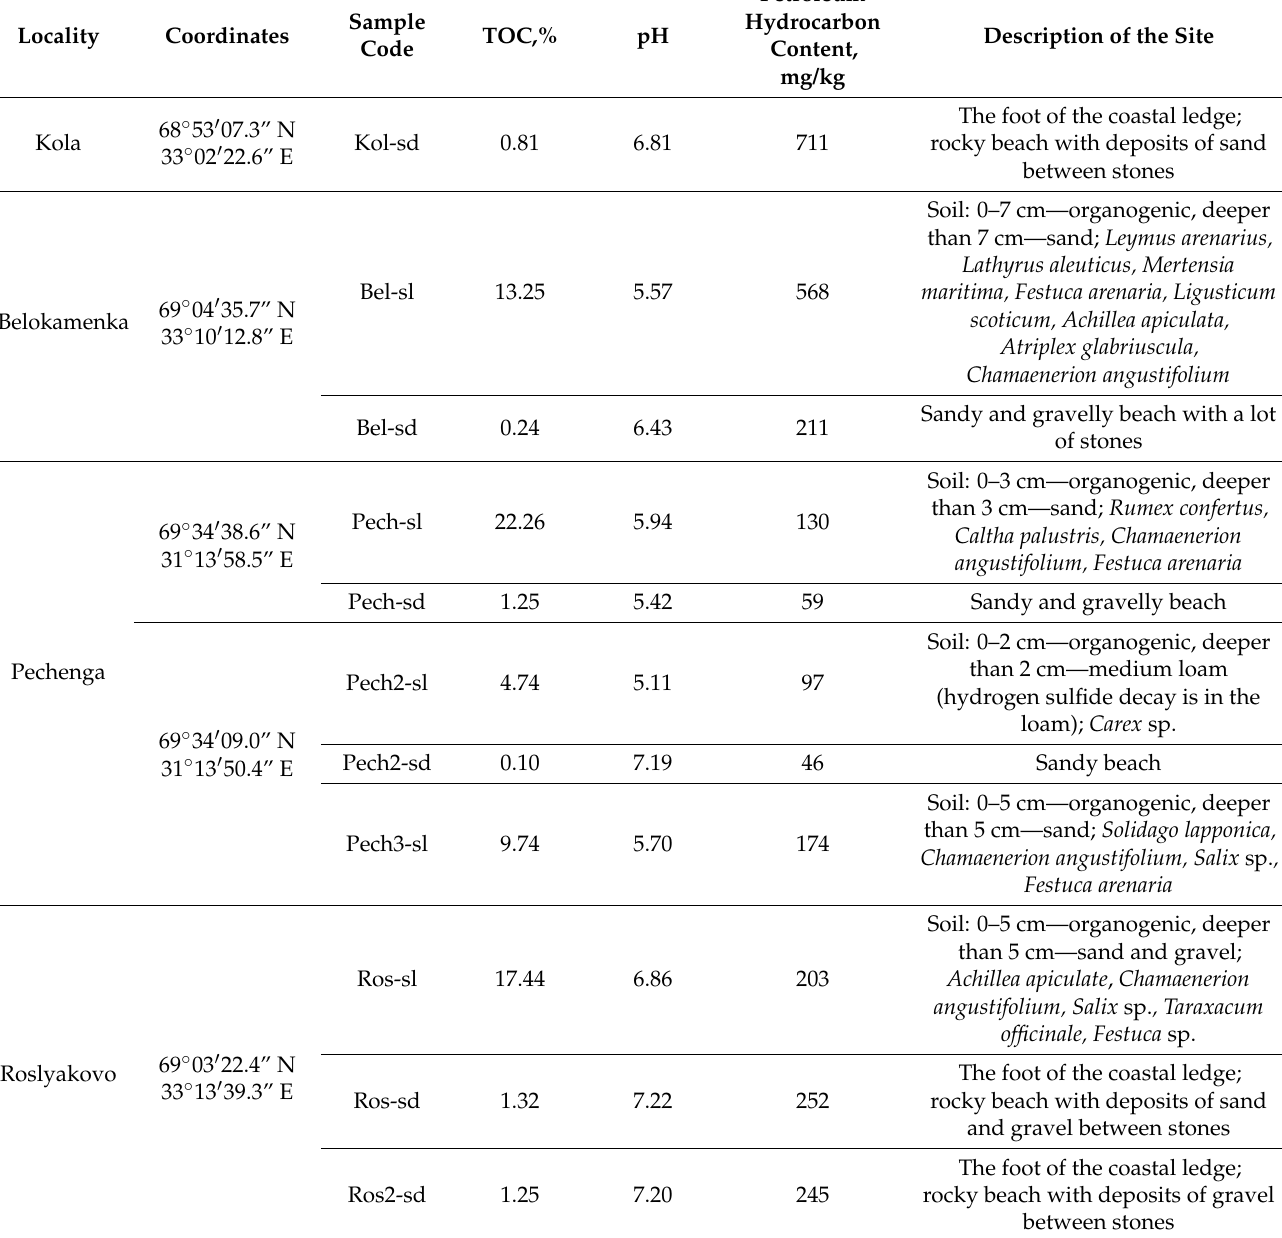
Table 1. Characteristics of soils on the Barents Sea coast of the Kola